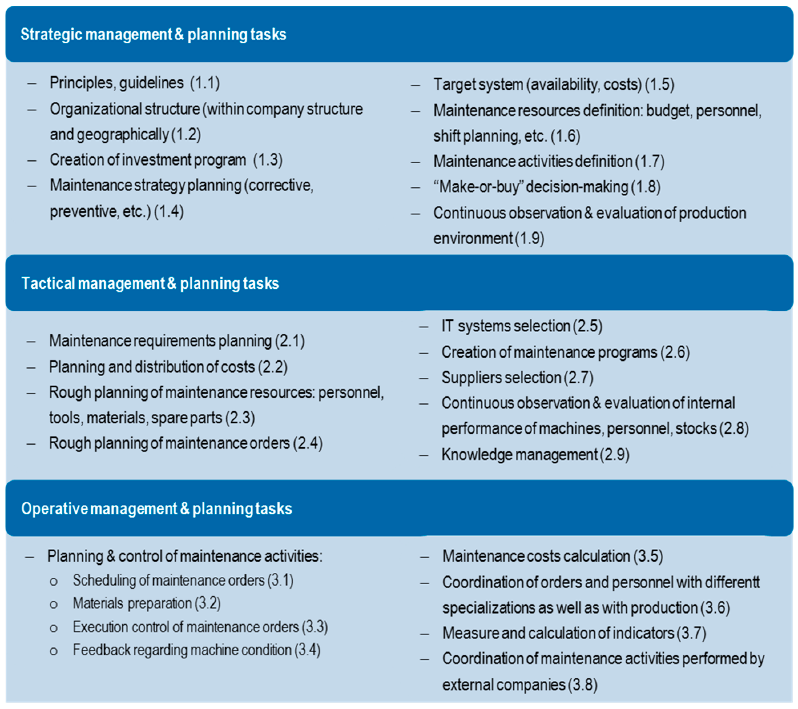
Figure 4. Production management and planning tasks acc. to time horizons (own elaboration).